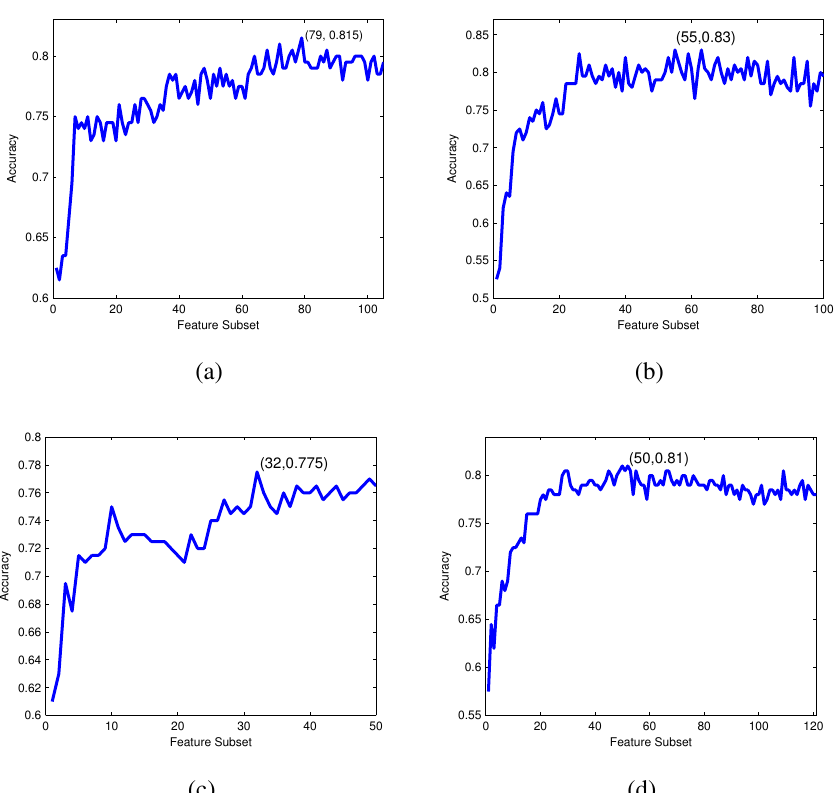
Figure 4. IFS curves for CTD, bi-profile Bayes, PseAAC and PSSM. ( a ) The IFS curve: the values of accuracy against the CTD feature subsets; ( b ) the IFS curve: the values of accuracy against the bi-profile Bayes feature subsets; ( c ) the IFS curve: the values of accuracy against the PseAAC feature subsets; ( d ) the IFS curve: the values of accuracy against the PSSM feature subsets.